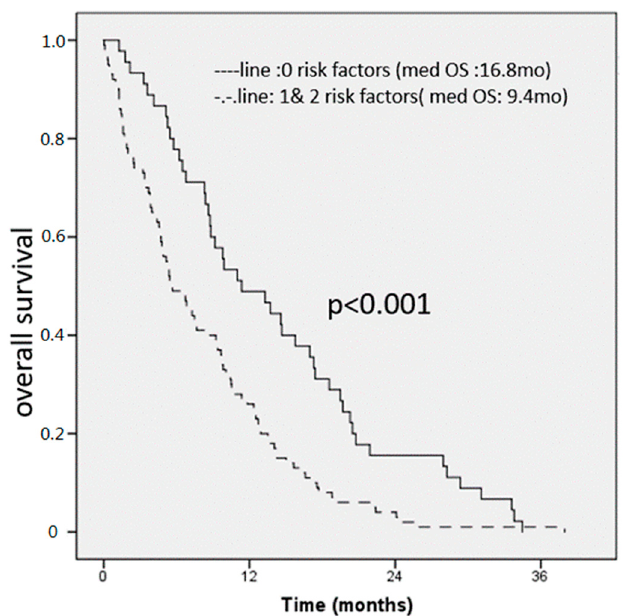
Figure 1. Overall survival score for all patients (n0148). An elevated CRP and NLR were found to be independent prognostic factors for OS, patients with 0 risk factors had 16.8 months, compared to 9.4 months for patients with 1 or 3 risk factors respectively.